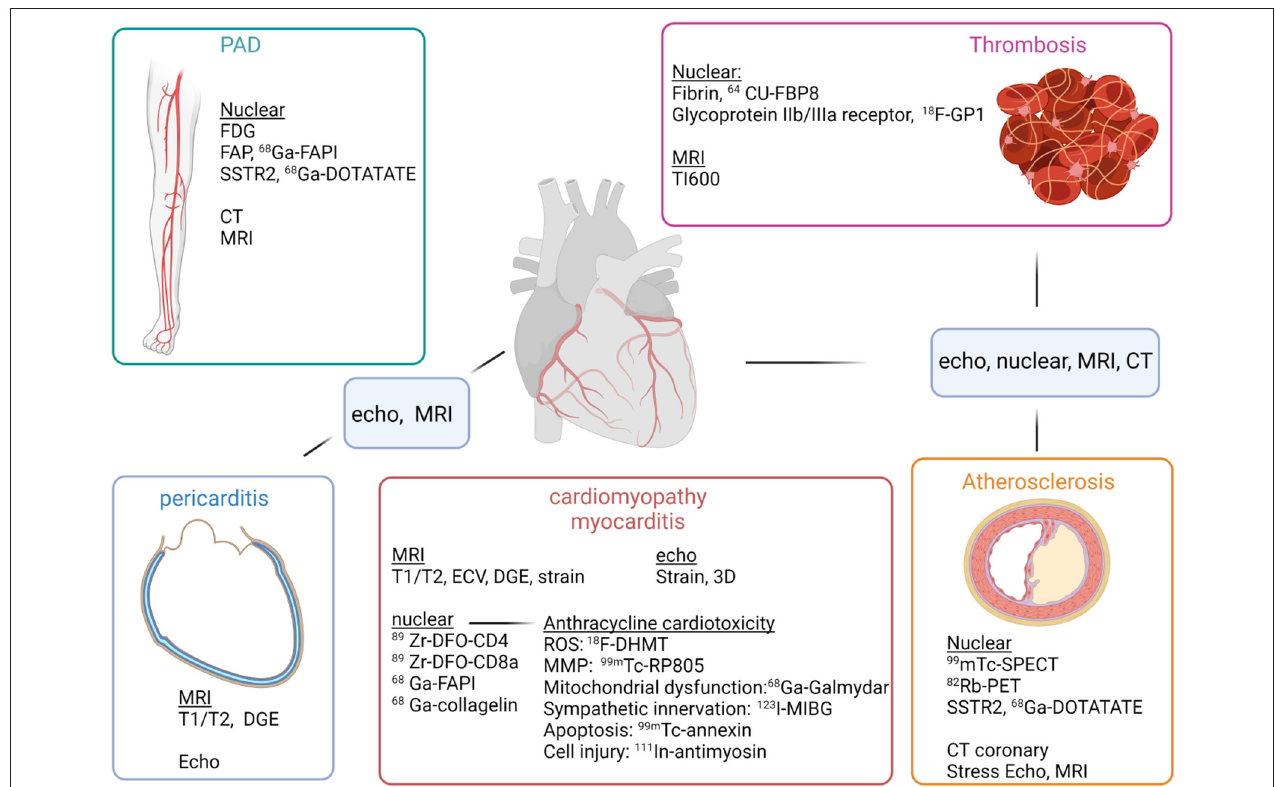
FIGURE 1 | Imaging modalities and evaluation of cardiotoxicities of oncologic therapies. For evaluation of peripheral artery disease (PAD) (top left), FDG, FAP and SSTR2 imaging may be able to identify vulnerable plaque, while CT and MRI can help evaluate degree of stenosis. For evaluation of thrombosis (top right), nuclear imaging may be able to identify early clot formation with radiotracers directed at fibrin or glycoprotine IIb/IIIa, and MRI can use a long inversion time to identify thrombus, as with TI600. For evaluation of cardiomyopathy/myocarditis (middle), echo and MRI can evaluate ejection fraction as well as myocardial strain. For myocarditis, MRI can evaluate tissue characteristics such as T1, T2 and DGE, which are now components of the Lake Louise criteria for myocarditis. Nuclear can evaluate for T cell infiltration using tracers targeting CD4, CD8 cells. Tracers directed against FAP, such as 68 Ga-FAPI has been shown to be increased in an animal model of checkpoint inhibitor myocarditis. Evaluation of pericarditis (bottom left), a complication of checkpoint inhibitors can be assessed by echo for detection of pericardial effusion, but with greater specificity MRI can identify edema and DGE. Atherosclerosis (bottom right) can be evaluated by traditional SPECT and PET techniques to evaluate for perfusion with stress and rest. CT coronary is now first line for evaluation of those with intermediate risk chest pain to rule out obstructive disease. Stress MRI or DGE can also be performed to evaluate for prior myocardial infarction as well as myocardial